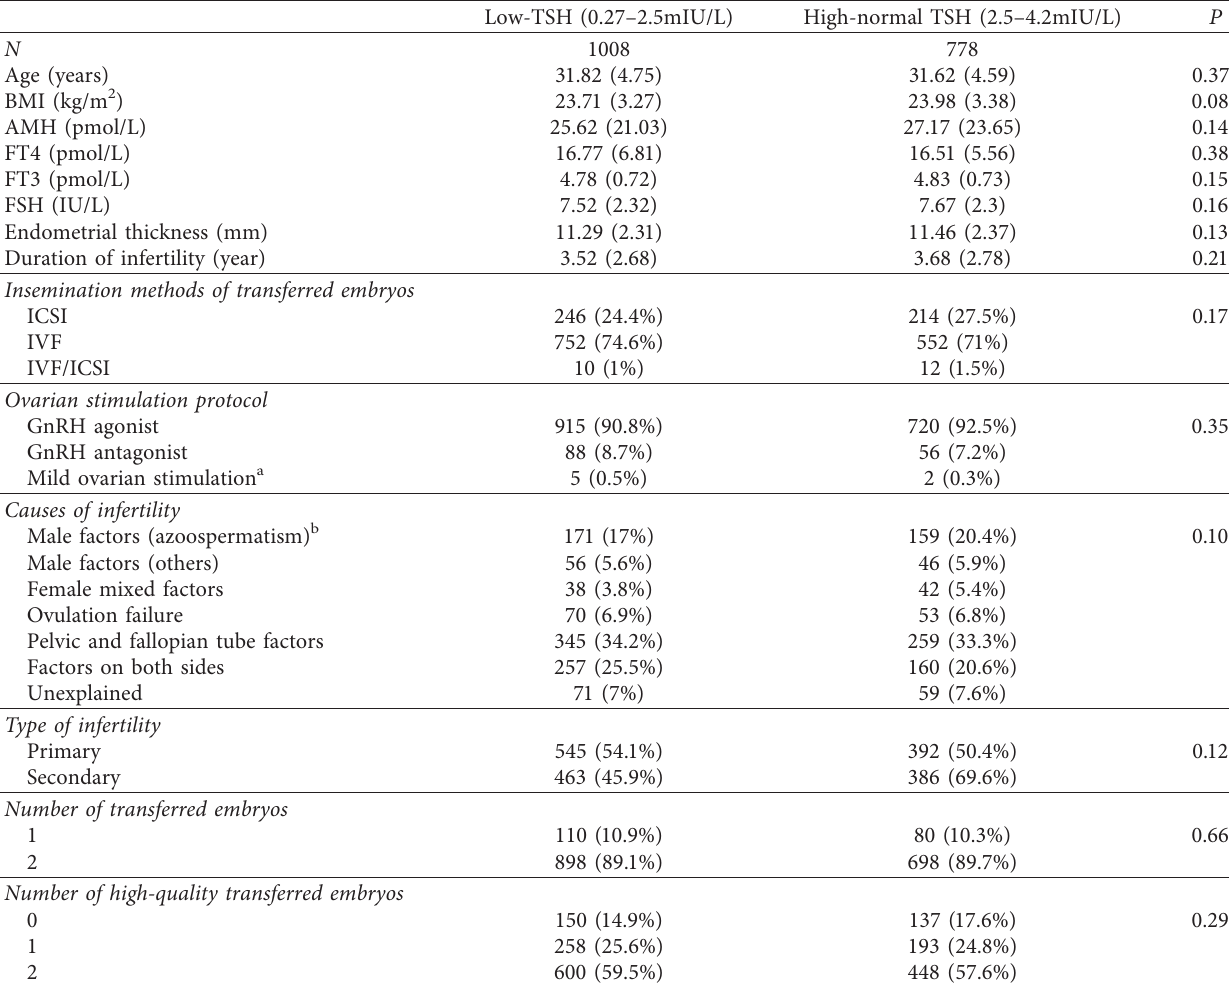
Figure 1: Flowchart of the inclusion of women undergoing the first fresh D3 embryo transfer cycles. Table 1: The general characteristics of the included women based on TSH